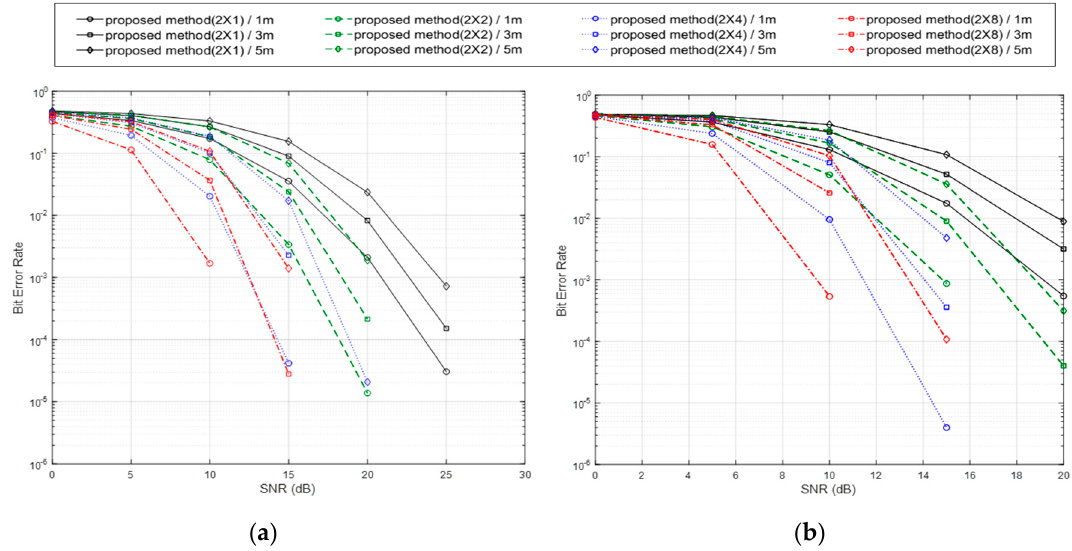
Figure 6. BER performance for the proposed backscatter method depending on the number of antennas of the reader. ( a ) Proposed MIMO encoding/decoding algorithm for increasing the data rate, ( b ) proposed MIMO encoding/decoding algorithm for improving the reliability.